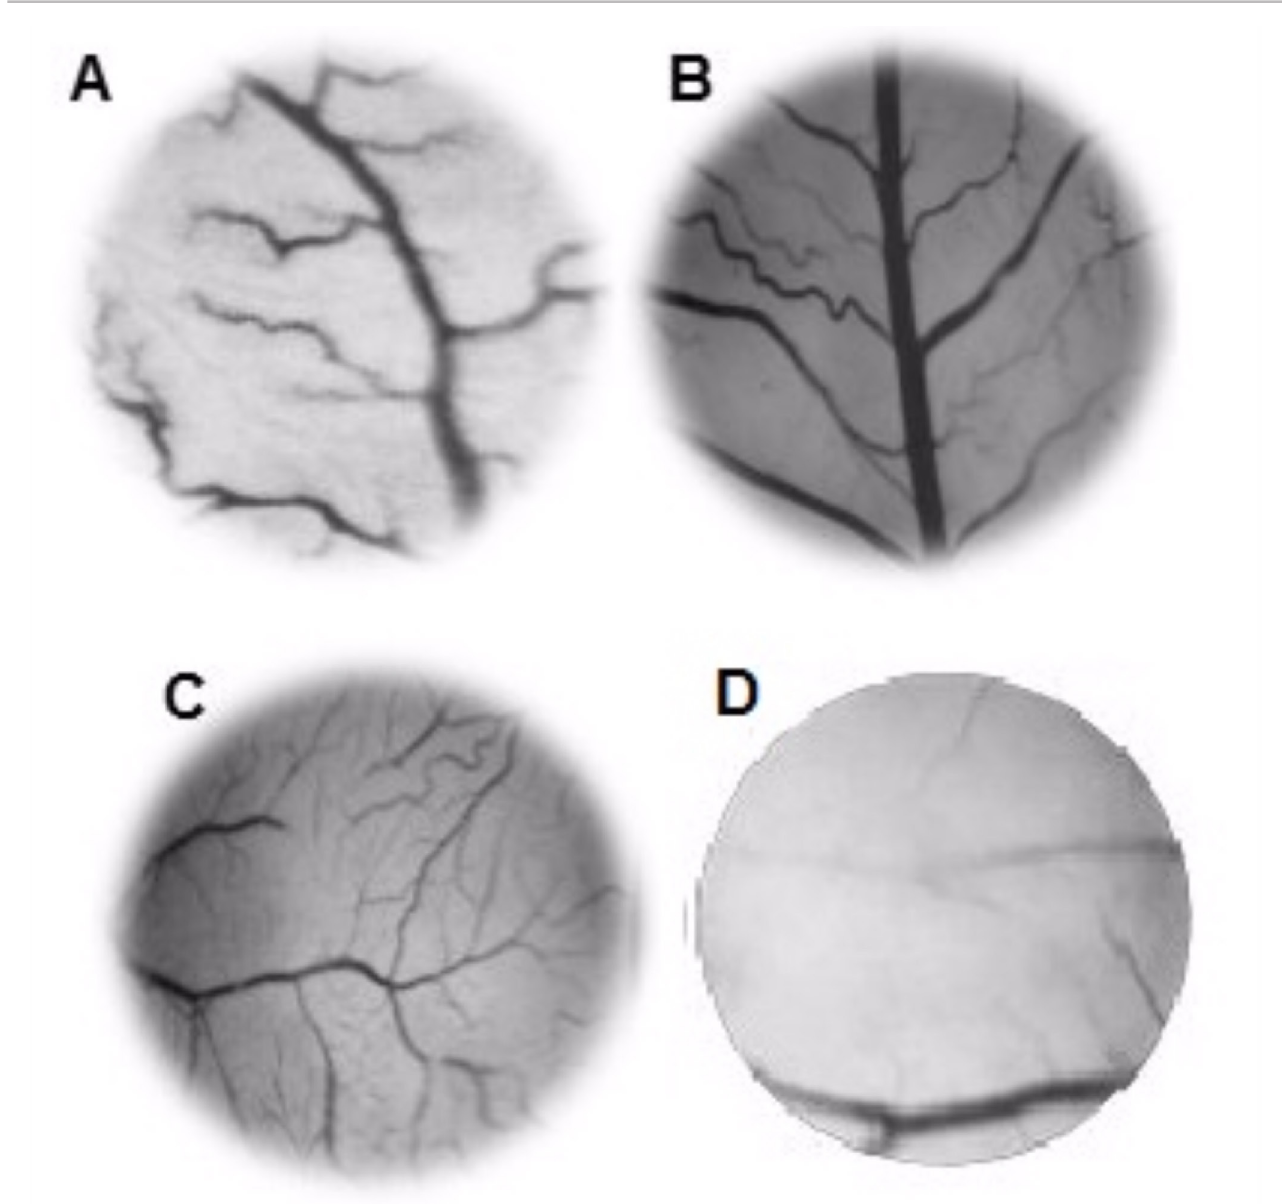
FIGURE 8 - Photographs of CAM treated with (A) PBS (B) blank implant (C) PLGA+AC implant (D)